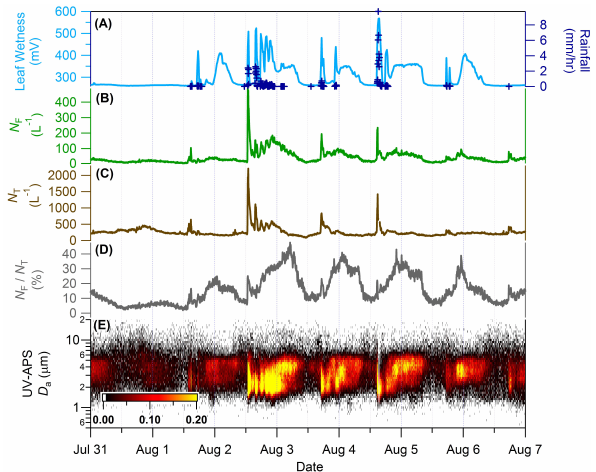
Fig. 2. Time series of measurement data showing repeated bursts of airborne biological particles with rain events. (A) Measured rain- fall (dark blue crosses) and corresponding leaf wetness (light blue trace). (B) Concentrations (L − 1 ) of supermicron fluorescent biopar- ticles ( N F ) and (C) total ( N T ) supermicron particles. (D) Fraction of fluorescent biological to total ( N F /N T ) . (E) Size-resolved fluo- rescent bioparticle concentrations measured with the UV-APS in- strument (color bar: d N F /dlog D A , L − 1 ) . Data are plotted against local time (Mountain Daylight Time, MDT). Rain data shown for non-zero